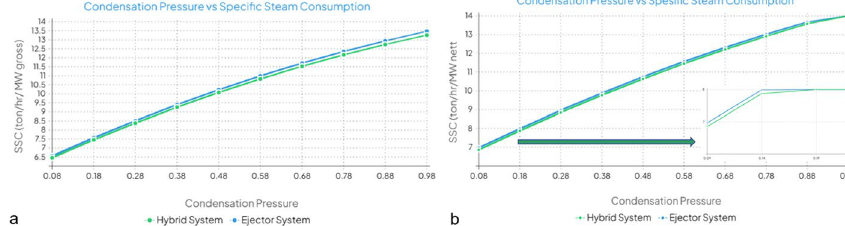
Fig. 20 Graphs showing the effect of condensation pressure on SSC for each type of GRS a SSC gross b SSC